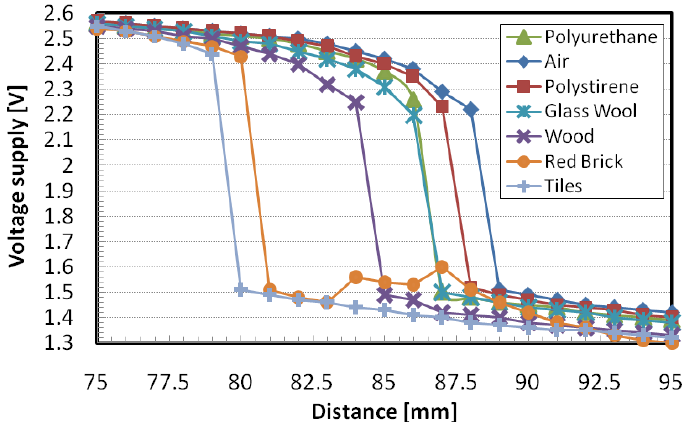
Figure 11. Transponder Voltage Supply for different distances and